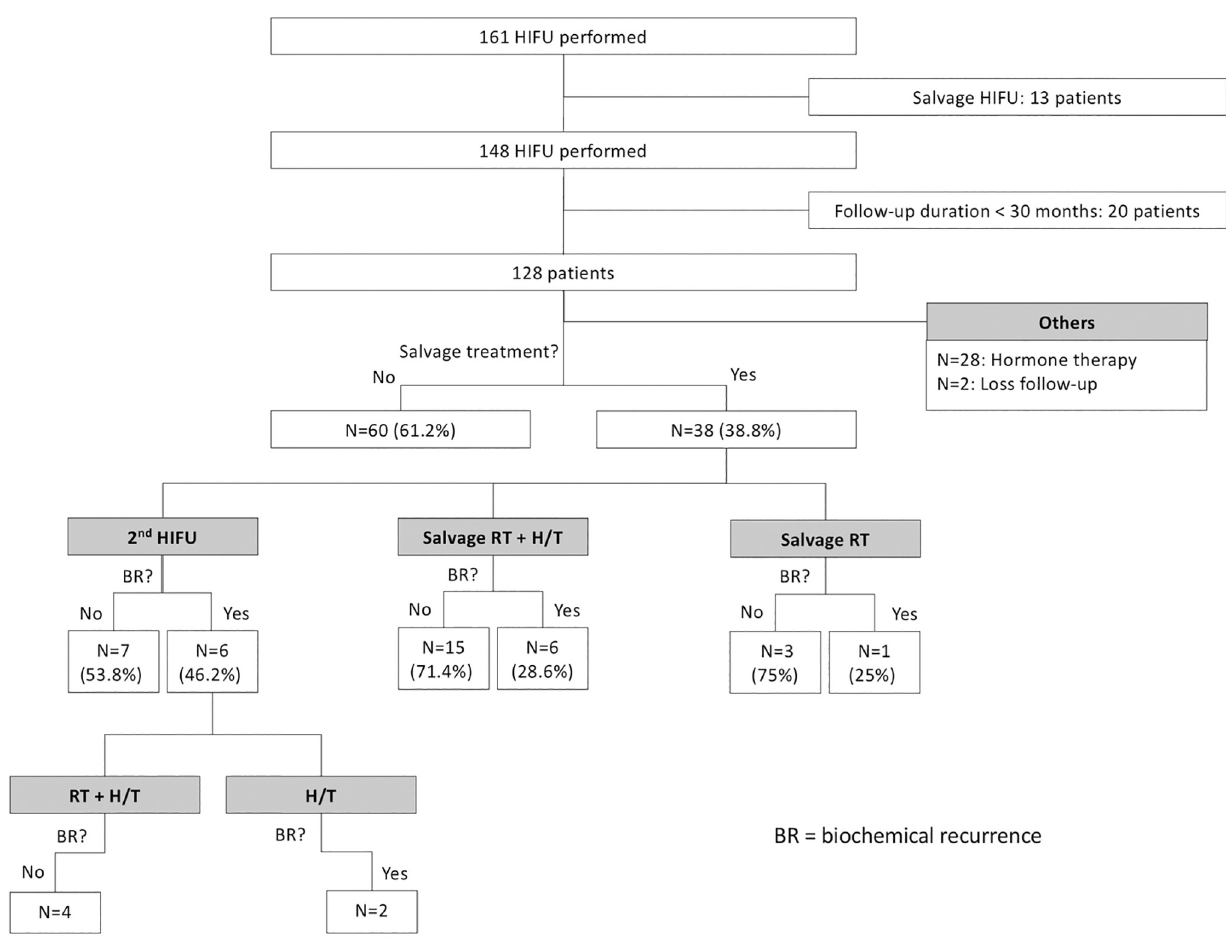
Fig 1. Outcome after salvage